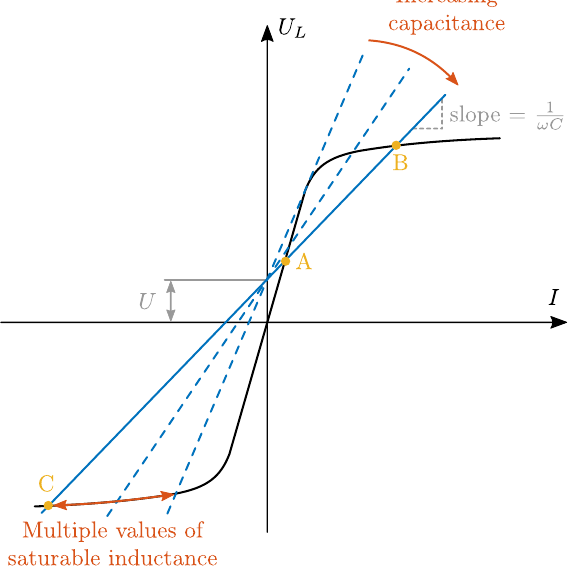
Figure 1. Graphical view of ferroresonance